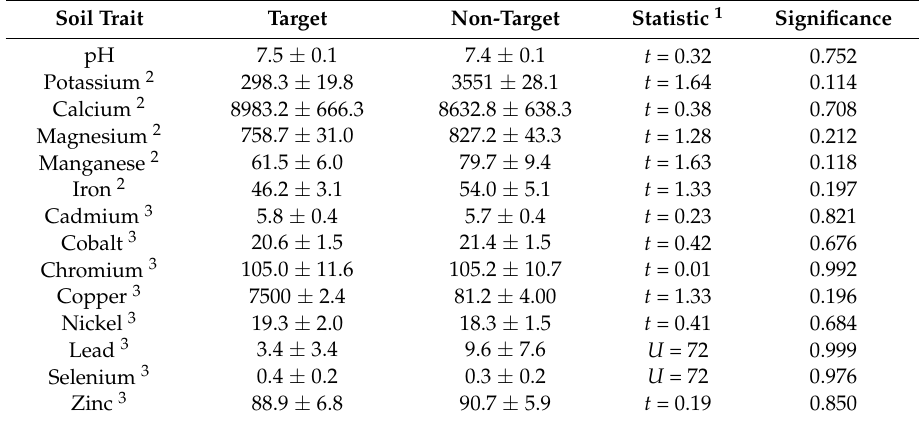
Table 3. The influence of proximity to Cycas micronesica trees on soil chemical traits in Ritidian Rock Outcrop soils on Guam. Target soils were collected underneath cycad trees. Non-target soils were collected 5-m from focal cycad trees. Means ± SE, n = 12.